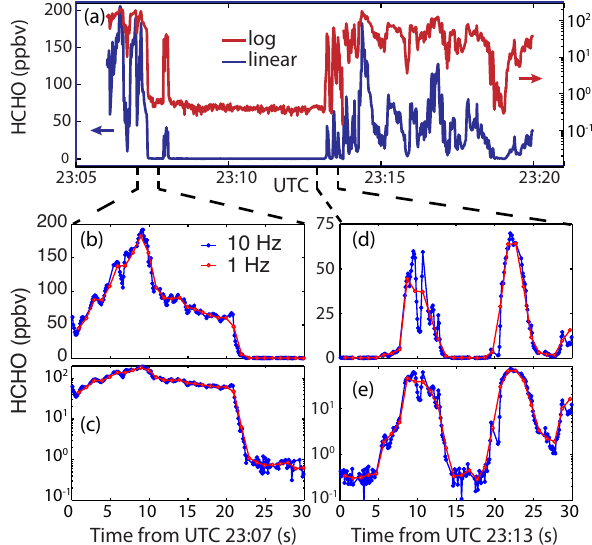
Figure 12. The time series obtained during the SEAC4RS campaign on the NASA DC-8 on 26 August 2013. The panel (a) shows the HCHO measured at a constant pressure altitude of 5km as the DC-8 sampled the plume from the Rim Fire in Stanislaus National Forest as the plume traveled eastward over California and Nevada. Note the linear and logarithmic scaling. Panels (b) and (c) show a window of 30s starting at 23:07UTC expanded with data averaged at 10 and 1Hz for linear and logarithmic scaling. Panels (c) and (d) show the same for the 30s window starting at